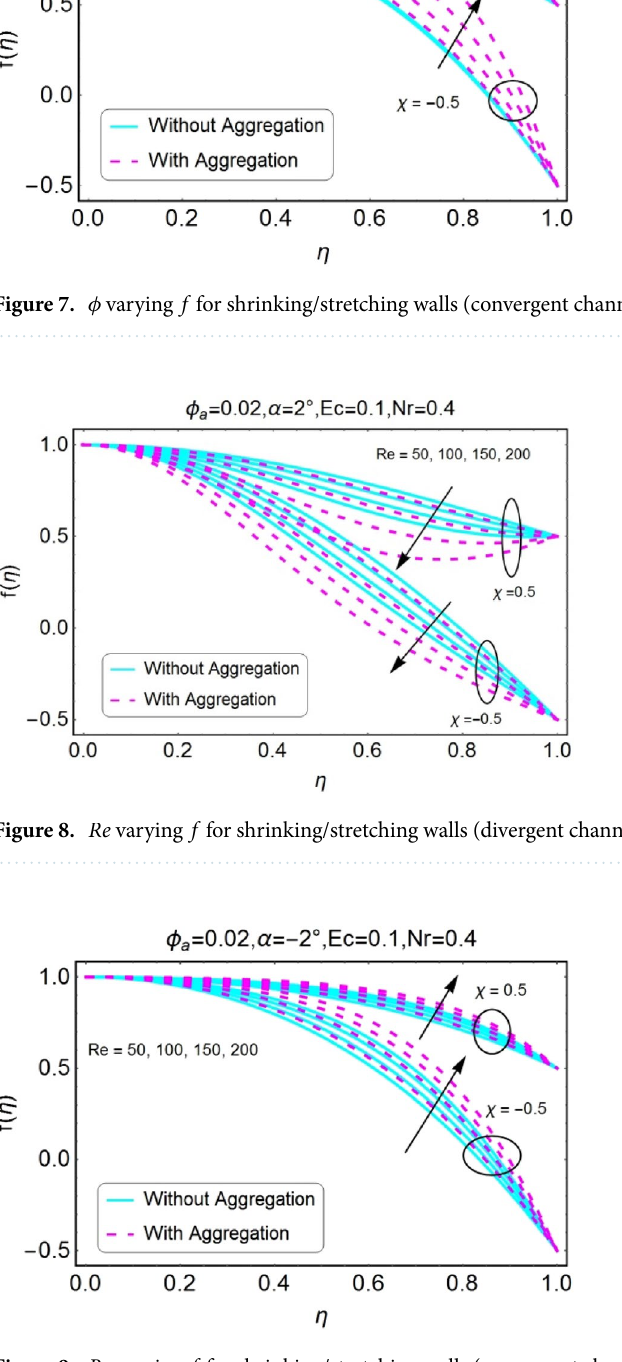
Figure 9. Re varying f for shrinking/stretching walls (convergent